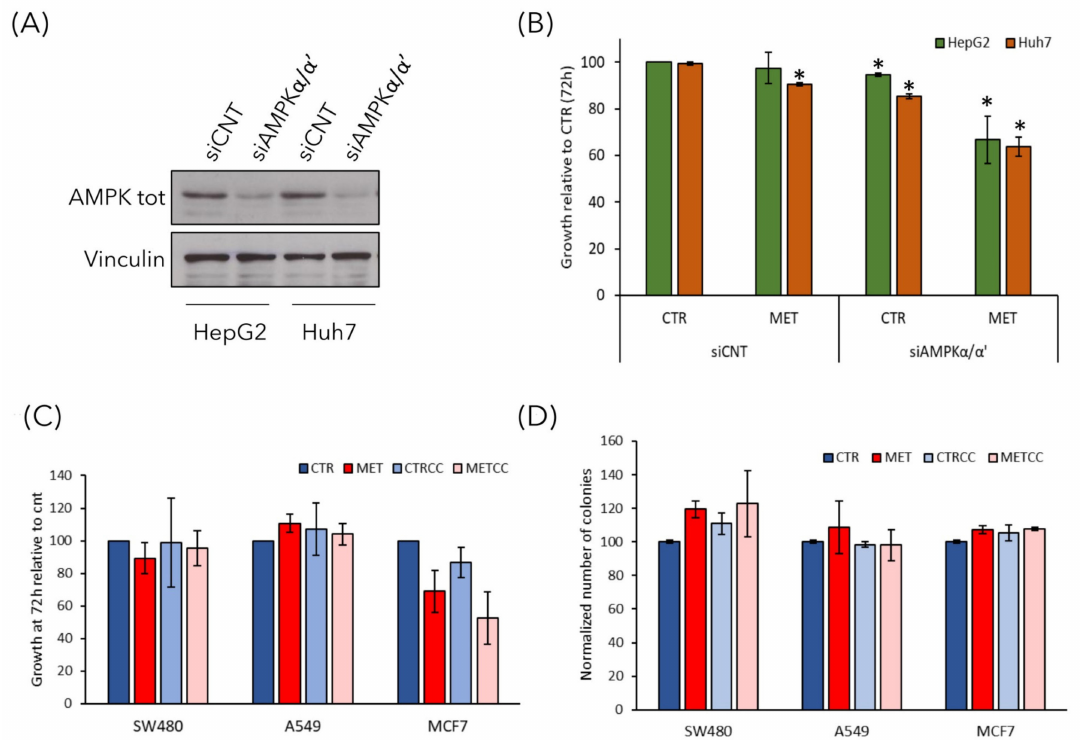
Figure 8. The e ff ect of high methionine and AMPK inhibition is specific for liver cancer cells. ( A , B ) Gene knockdown for AMPK α / α ’ in HepG2 and Huh7 cells was achieved by siRNA. ( A ) The level of endogenous AMPK α / α ’ protein was detected by immunoblot by using anti-AMPK total antibody. anti-tubulin antibody was used as loading control. ( B ) Cell growth of HepG2 and Huh7 cells transfected with siCNT or siAMPK α / α ’ was monitored for 72 h in regular medium (CTR) or in the presence of 1.5 g / L methionine (MET). Cell growth is expressed as a ratio on the growth in control medium. * p < 0.05 compared with siCNT cells. ( C ) Cell growth of SW480 colorectal cancer cells, A549 lung cancer cells, and MCF7 breast cancer cells was monitored until 72 h in regular medium (CTR) or in the presence of 1.5 g / L methionine (MET) and / or 2 µ M Compound C. Cell growth is expressed as a ratio